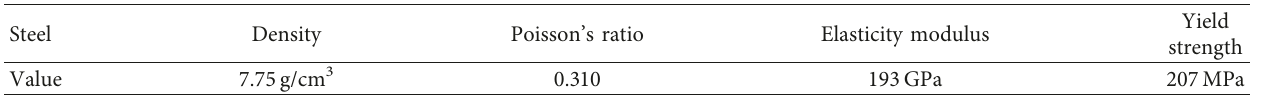
Figure 12: Flat pressure simulation. Table 5: Basic properties of